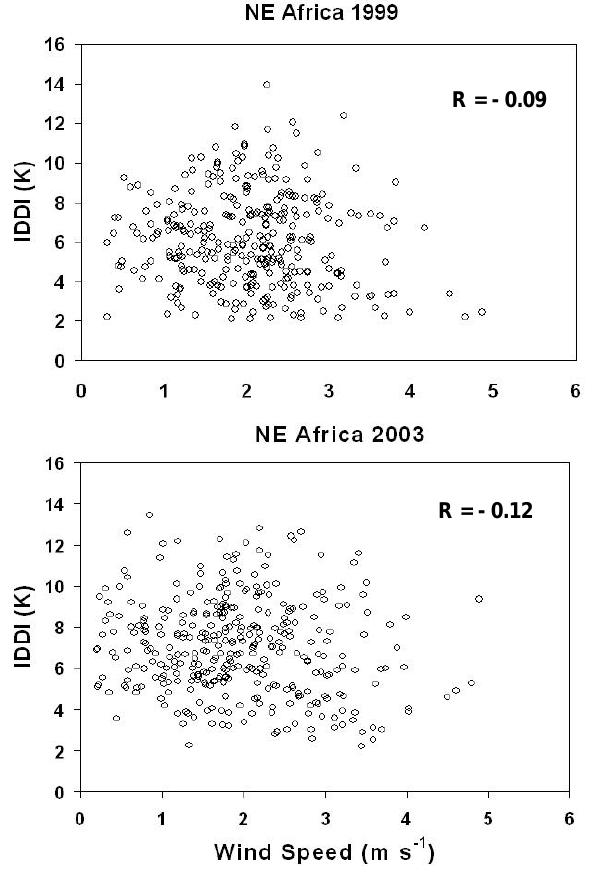
Fig. 8. Scatter plot of daily IDDI versus wind speed for NE Africa. The solid line represents linear least-squares fit to the data